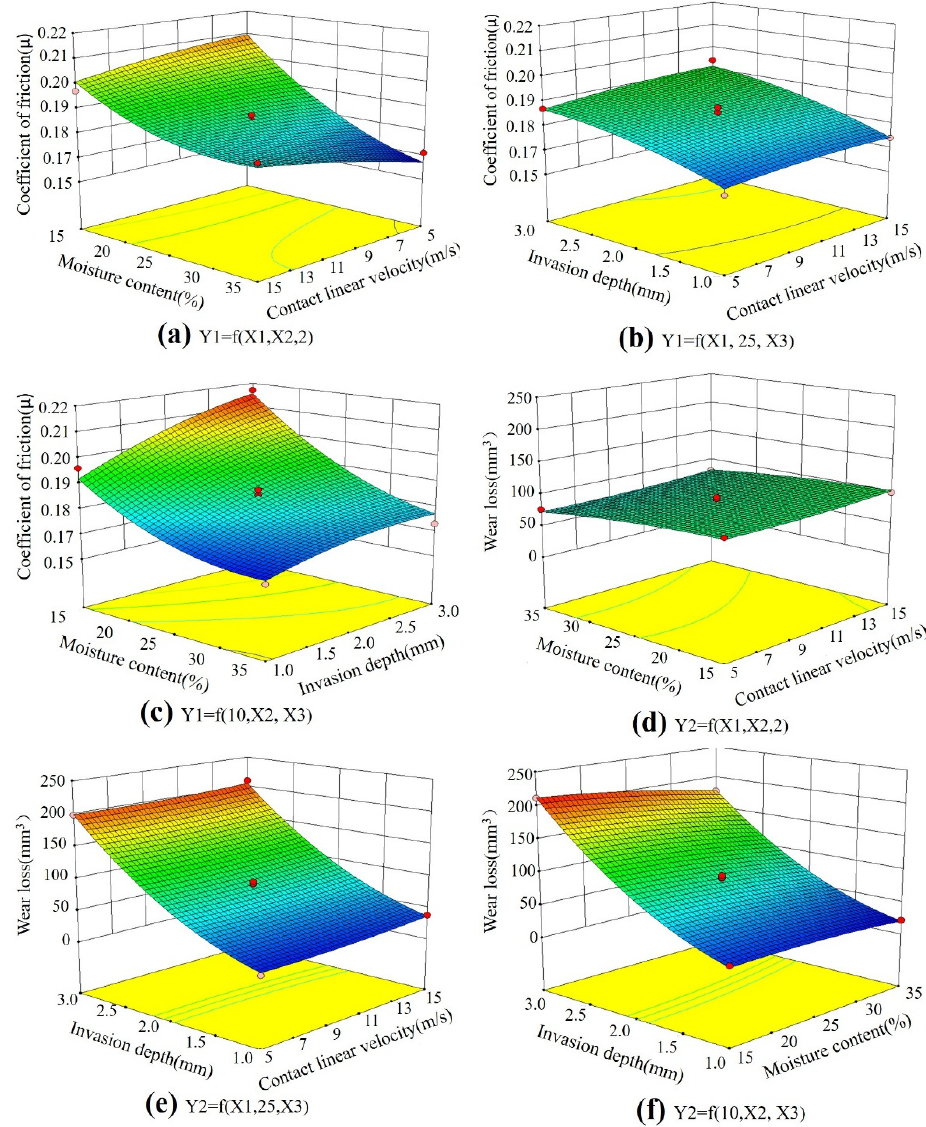
Figure 11. Effects of interactive factors on the coefficient of friction (( a ) Y 1 = f(X 1 , X 2 , 2), ( b ) Y 1 = f(X 2 , 5, X 3 ), ( c ) Y 1 = f(10, X 2 , X 3 )) and wear loss (( d ) Y 1 = f(X 1 , X 2 , 2), ( e ) Y 1 = f(X 2 , 5, X 3 ), ( f ) Y 1 = f(10, X 2 , X 3 )).